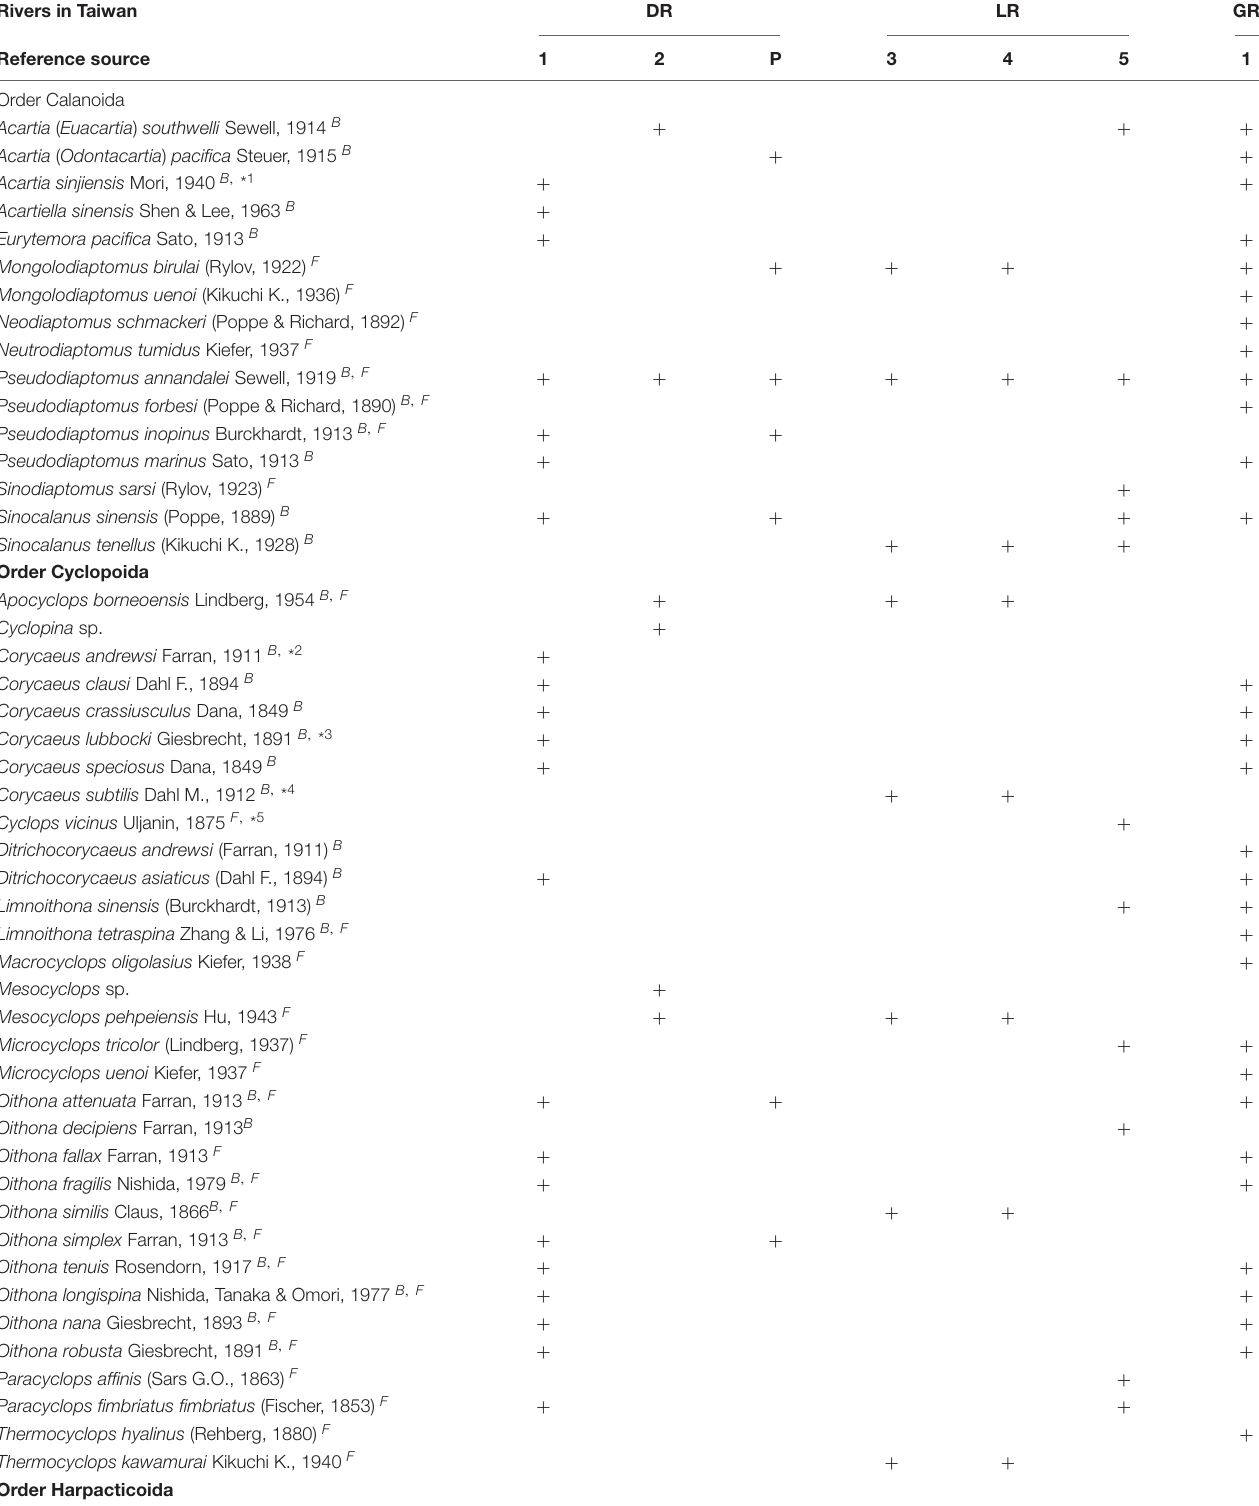
TABLE 6 | List of previously recorded brackish-water and freshwater copepod species from the Danshuei (DR), Lanyang (LR), and Gaoping (GR) rivers in Taiwan, along with those recorded from the Danshuei River in the present